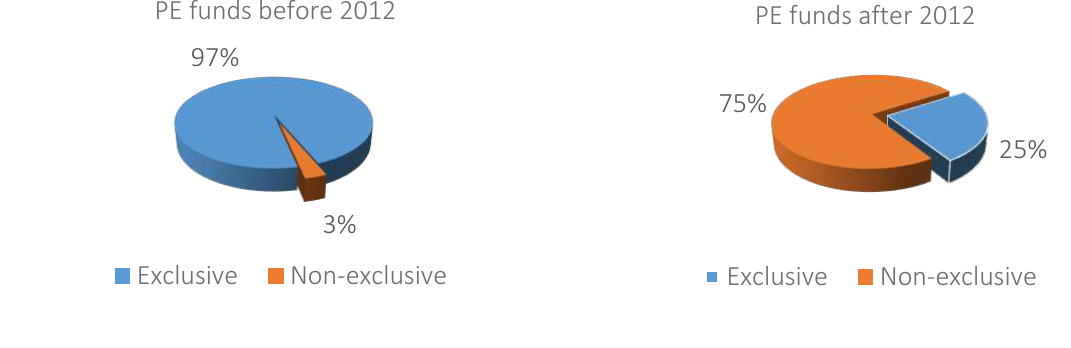
Figure 2. Exclusive funds distribution by interest